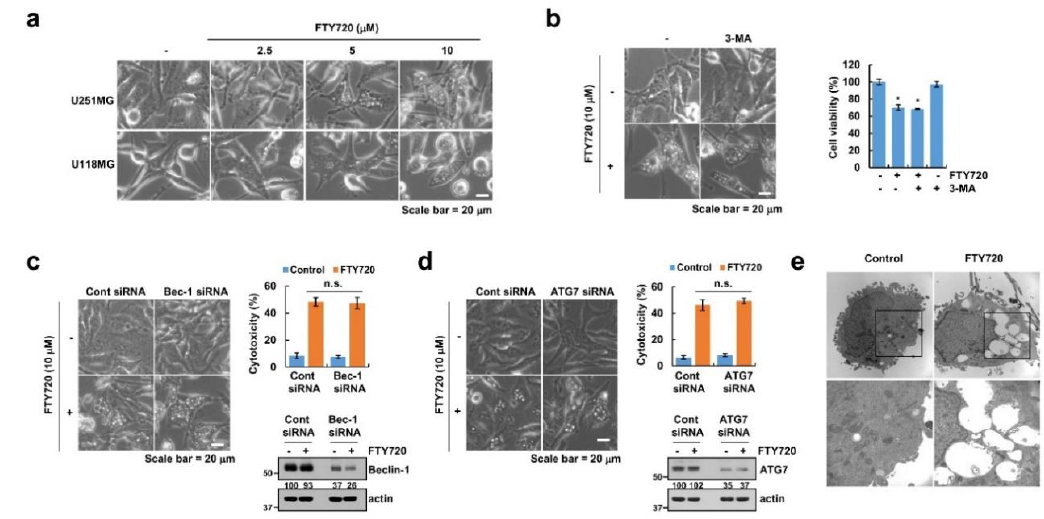
Figure 2. Effect of FTY720 on autophagy in human glioma U251MG cells. ( a ) Cells were treated with the indicated concentrations of FTY720 for 6 h. ( b ) U251MG cells were pretreated with 1 mM 3-MA for 30 min, and then treated with 10 μM FTY720 for 24 h. ( c , d ) U251MG cells were transfected with Beclin-1 (Bec-1) siRNA ( c ), ATG7 siRNA, ( d ) and/or control siRNA (Cont siRNA). Twenty-four hours after transfection, cells were treated with 10 μM FTY720 for 24 h. ( e ) U251MG cells were treated with 10 μM FTY720 for 12 h, and cell morphology was detected by electron microscopy. Cell morphology was detected by interference light microscopy. The mean number of microscopic images ( a – e ) per sample is 10, and these images were taken randomly. Cell viability was determined by XTT assay ( b ). Protein expression was detected by Western blotting and cell death was analyzed by LDH assay ( c , d ). The values in the graphs ( b – d ) represent the mean ± SD of three independent experiments. * p < 0.01 compared to the control. n.s. = no significance.